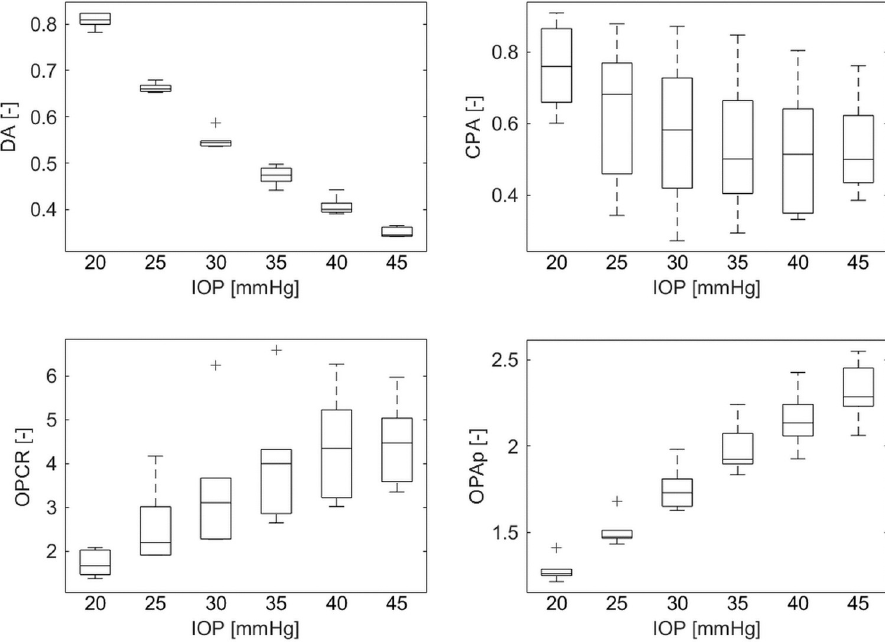
Fig 5. Boxplots of deformation amplitude (DA), corneal pulse amplitude (CPA), ocular pulse based corneal rigidity index (OPCRI), and physical ocular pulse amplitude (OPAp) normalized to their baseline values obtained at 15 mmHg, for different IOP